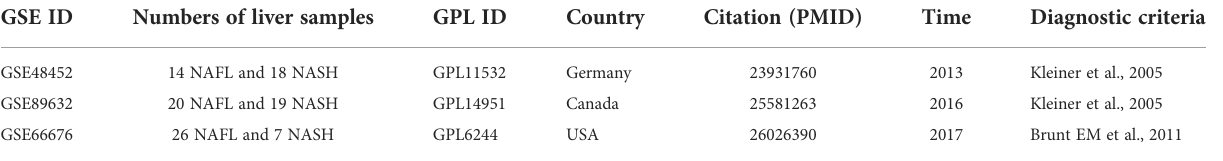
TABLE 1 Details of the GEO NAFLD